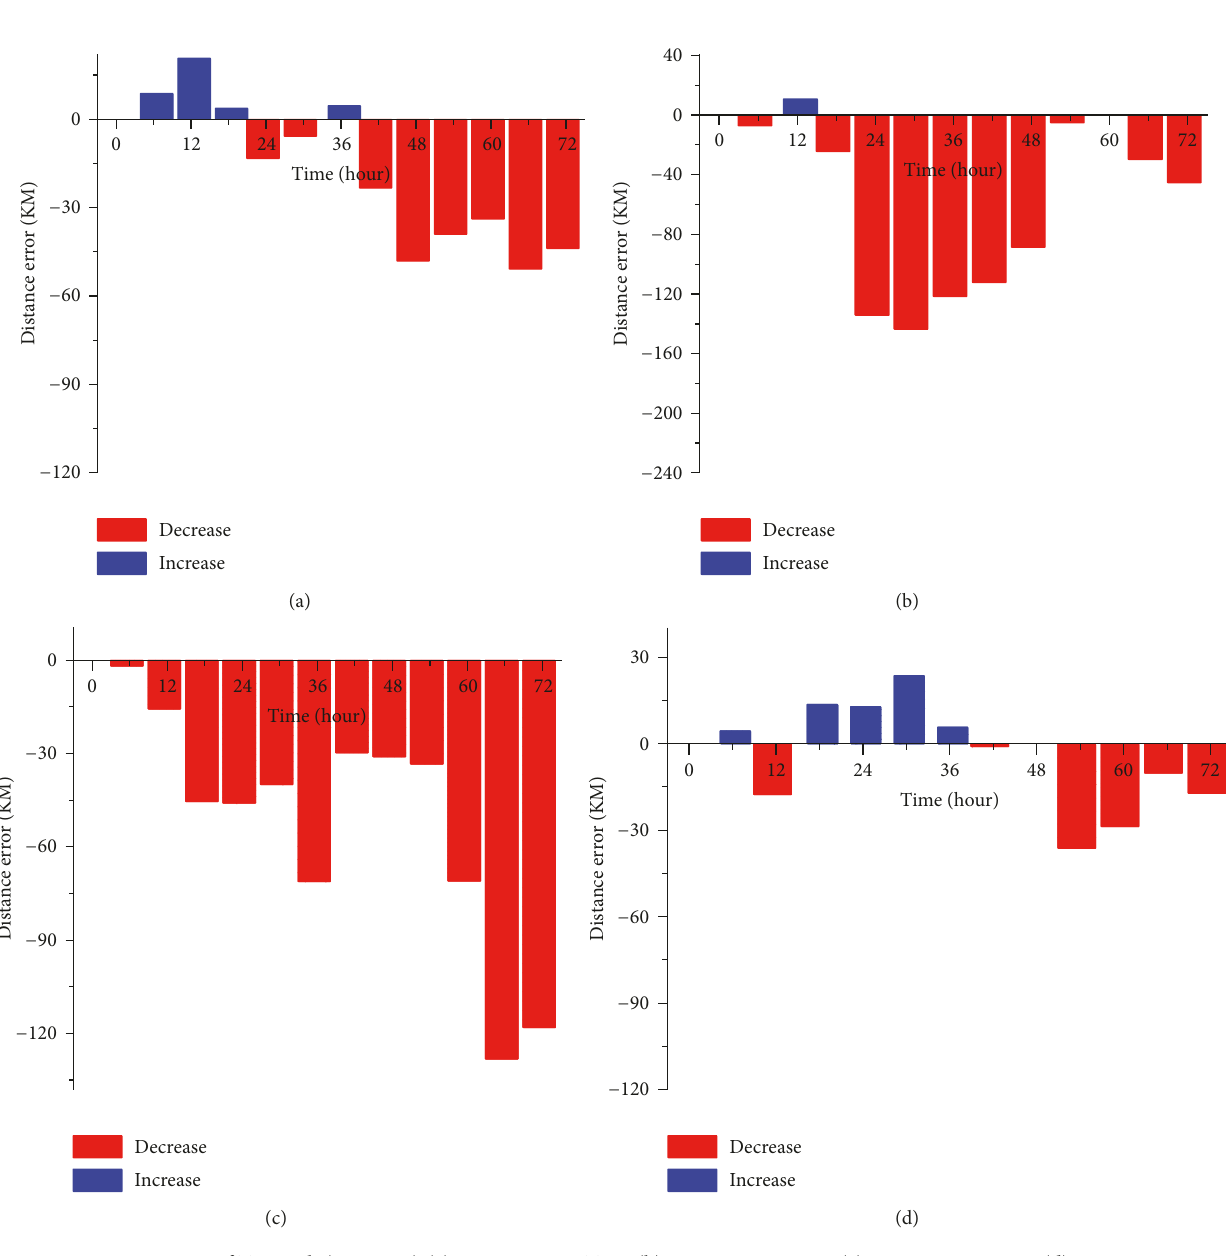
Figure 6: Improvement of TC track (unit: Km) (a) AIRS_GRD-CTRL; (b) AIRS_GRD-AIRS; (c) AIRS_SYB –AIRS; (d) AIRS_SYB_GRD-